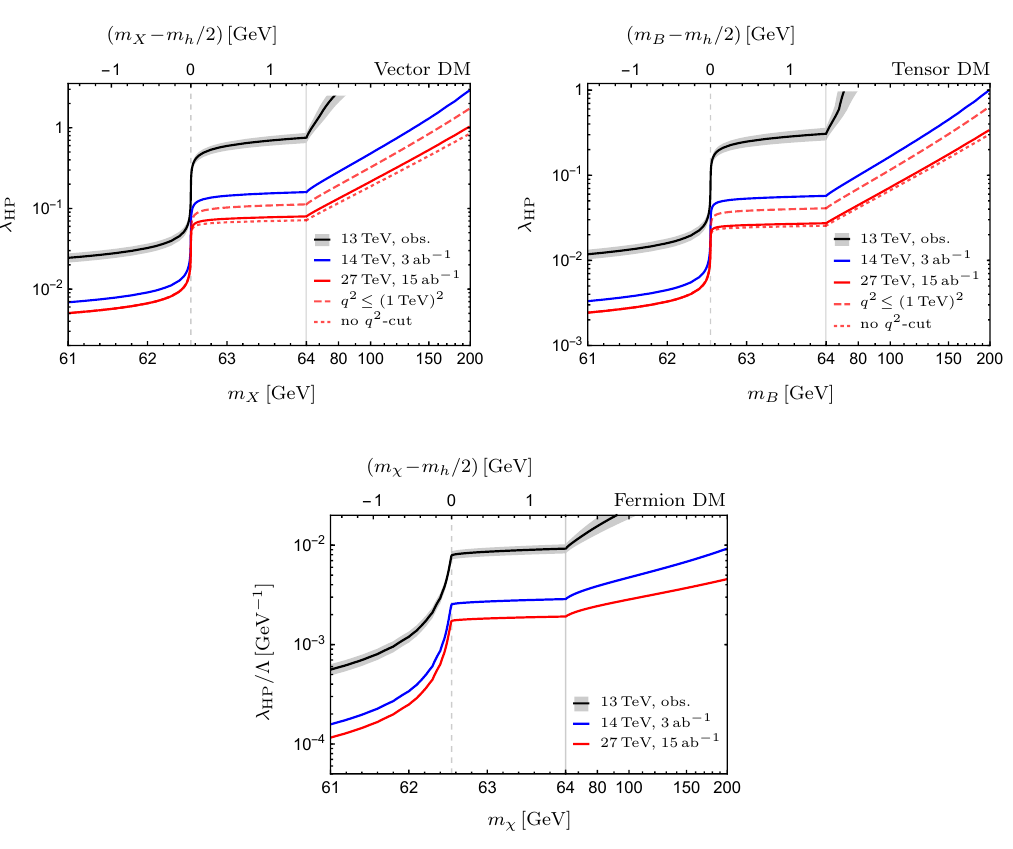
Figure 8 . 95 % CL upper limits on the Higgs-portal coupling for the case of vector (upper left), tensor (upper right) and Majorana fermion DM (lower panel). The black curve (and grey band) denotes the 13 TeV LHC observed limit (and the signal uncertainty). The blue and red curves denote the 14 TeV HL- and 27 TeV HE-LHC projections, respectively. For the vector and tensor models, we use a cut-o(cid:11) for the integral in eq. (3.3) as discussed in the text. The dashed and dotted light red curves indicate the HE-LHC limits if a 1 TeV cut-o(cid:11) or no cut-o(cid:11) is used instead, respectively. To resolve the resonant region, for the abscissa we impose a scale break at a DM mass of 64 GeV, below (above) which we plot the mass linearly